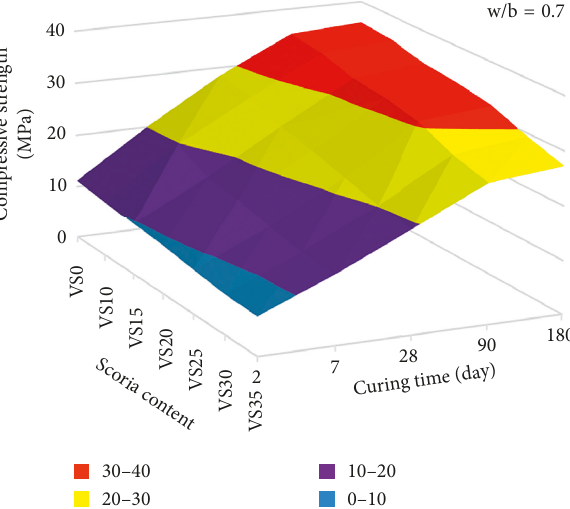
Figure 9: Development of compressive strength of VS-based binder concretes with curing ages at w/b �